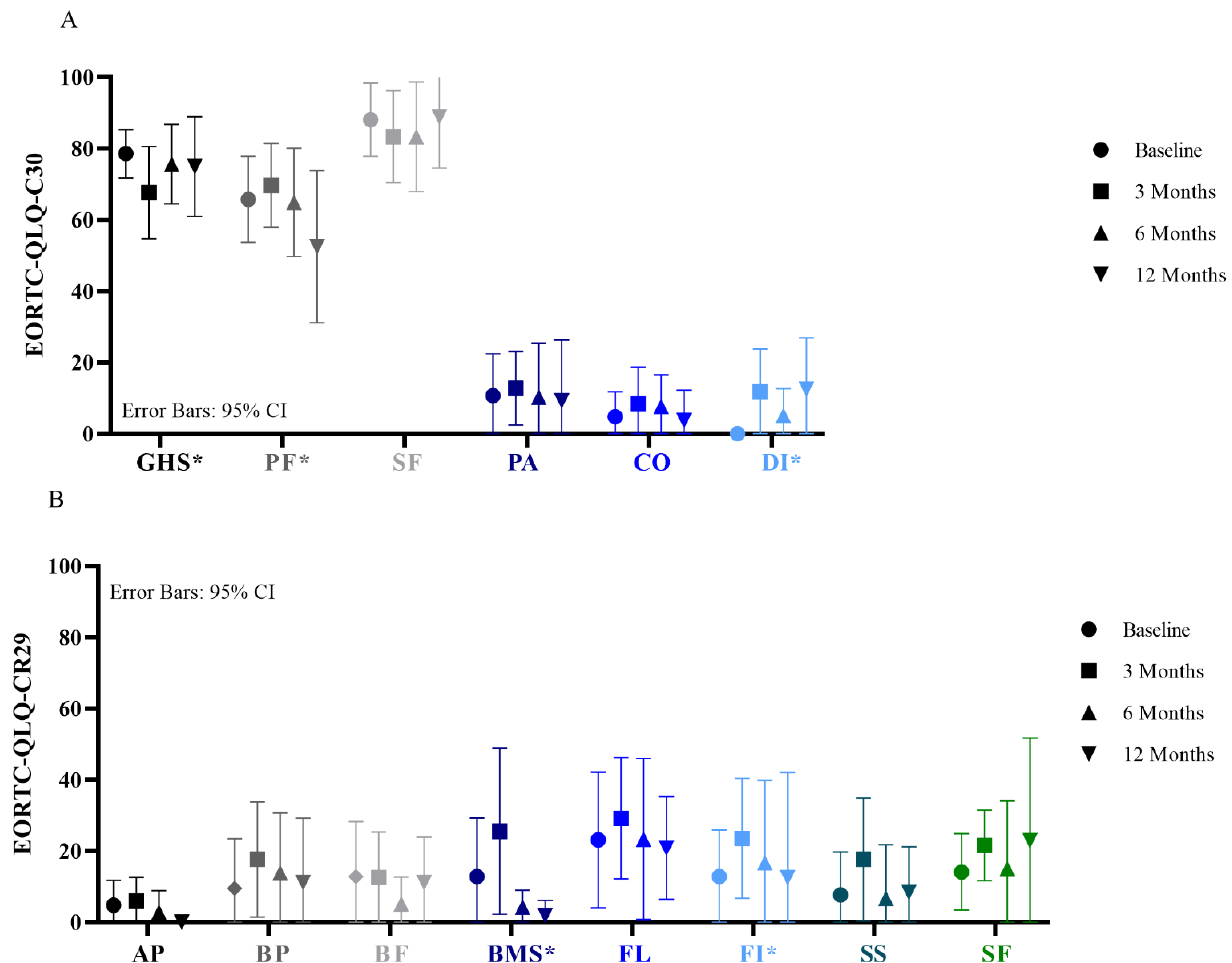
Figure 4. Quality of life according to the EORTC-QLQ-C30 ( A ) and EORTC-QLQ-CR29 ( B ). Functional scales, higher scores mean better results; GHS = Global health status; PF = Physical functioning; SF = Social functioning. Symptom scales, lower scores mean better results; PA = Pain; CO = Constipation; DI = Diarrhea; AP = Abdominal pain; BP = Buttock pain; BF = Bloating; BMS = Blood and mucus in stool; FL = Flatulence; FI = Fecal incontinence; SS = Sore skin; SF = Stool frequency. * Difference of 10 points is considered clinically relevant.